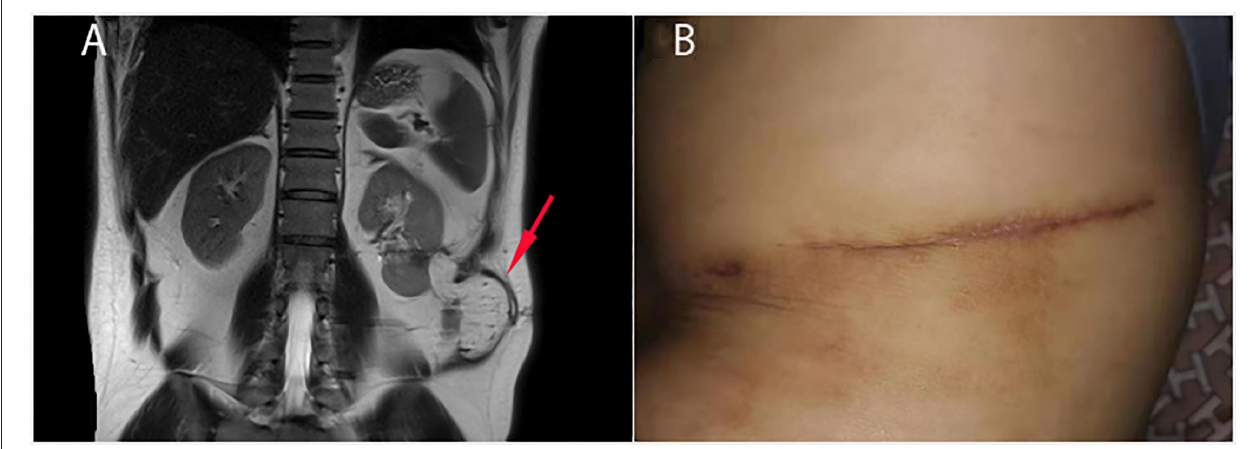
FIGURE 3 | Follow-up 6 months after the operation. (A) MR examination showed that the omental flap tightly covered the left kidney (red arrow) and cut the kidney off from the flank muscle. (B) The NCF and the surgical incision were completely